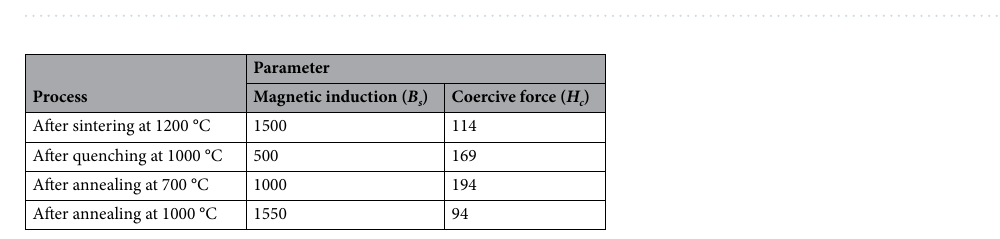
Figure 7. B–H hysteresis curve for sample after sintering at 1200 °C, after quenching at 1000 °C, after annealing at 700 and 1000 °C.